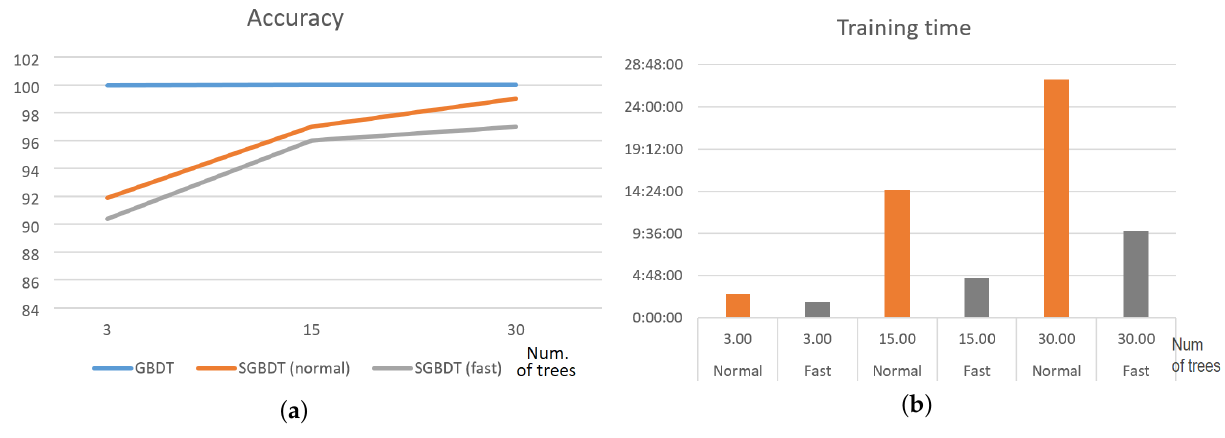
Figure 4. The comparison of the accuracy of gradient boosting decision tree model trained in centralized and federated mode with different encryption parameters ( a ), and duration of the training process for different settings of the encryption protocol ( b